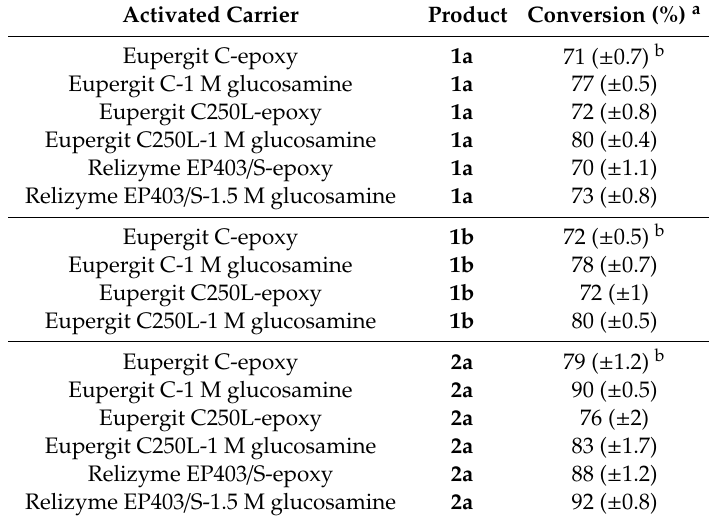
Table 2. Enzymatic synthesis of Cefonicid, Cefamandole and Cefazolin by acylation with esters 1 and 2 (Scheme 2) catalyzed by di ff erent